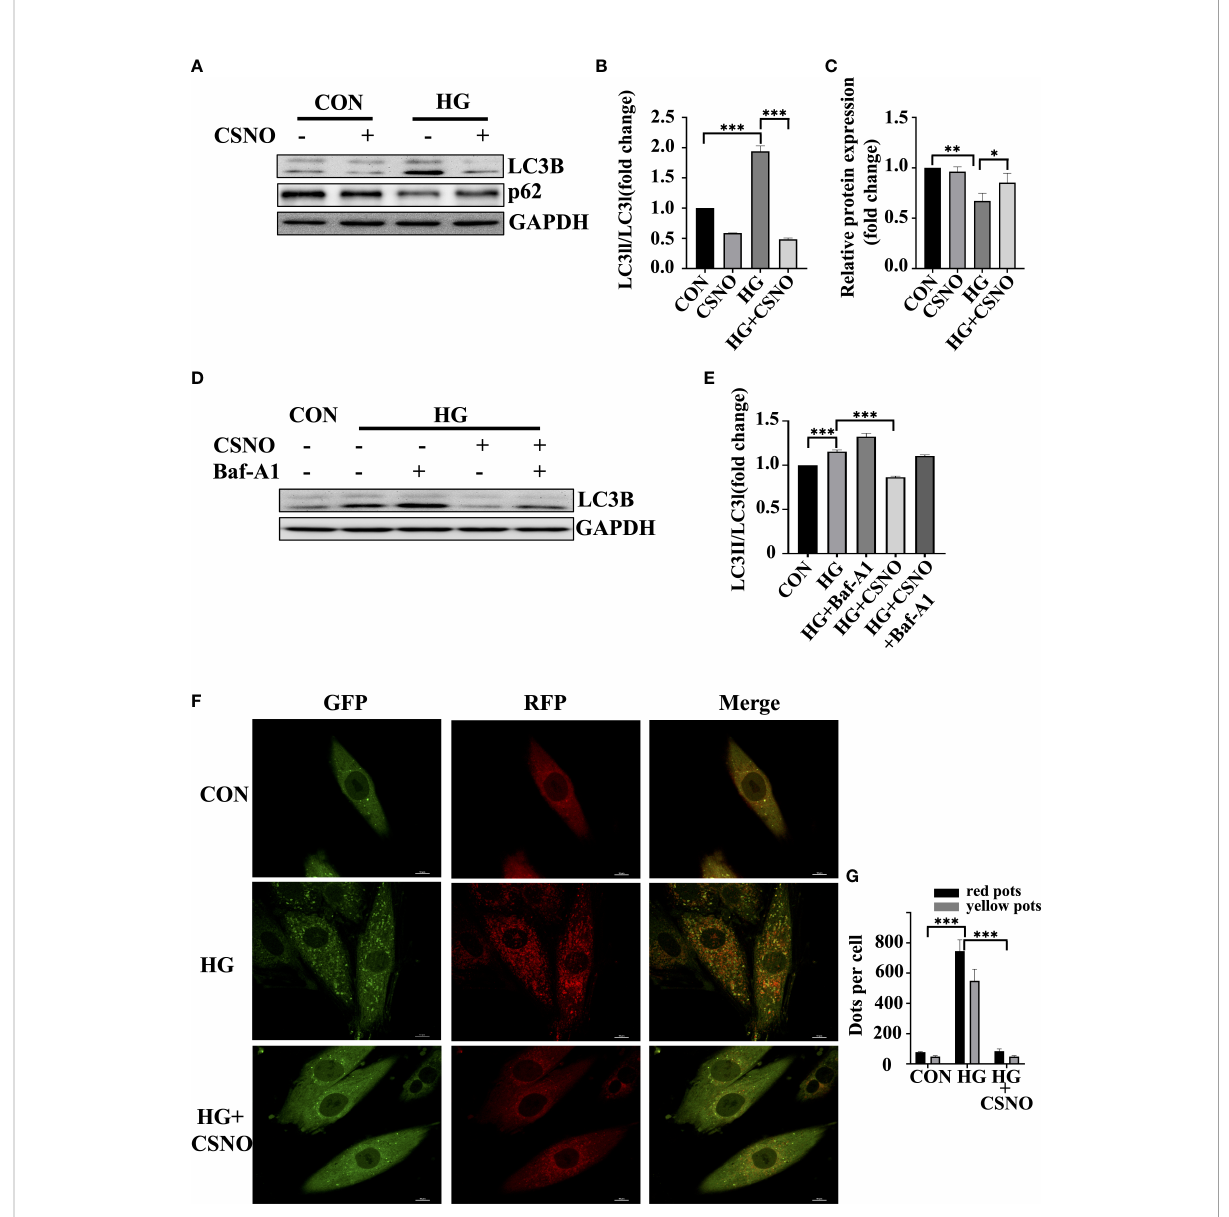
FIGURE 6 CSNO inhibited high glucose-induced excessive autophagy. (A-C) The expression levels of P62, LC3 II/I and GAPDH were analyzed by Western blot. The protein band diagram and quantitative statistical diagram are shown. (D, E) After adding the autophagy inhibitor Baf-A1,the expression of LC3 II/I and GAPDH was analyzed by Western blot. The protein band diagram and quantitative statistical diagram are shown. (F) An adenovirus expressing GFP-RFP-LC3 protein was used to detect autophagic fl ux. Scale bar=10 m m. (G) To quantify yellow and red LC3 dots per cell in each condition, Image-Pro Plus was used. * represents p < 0.05; ** represents p < 0.01; *** represents p <